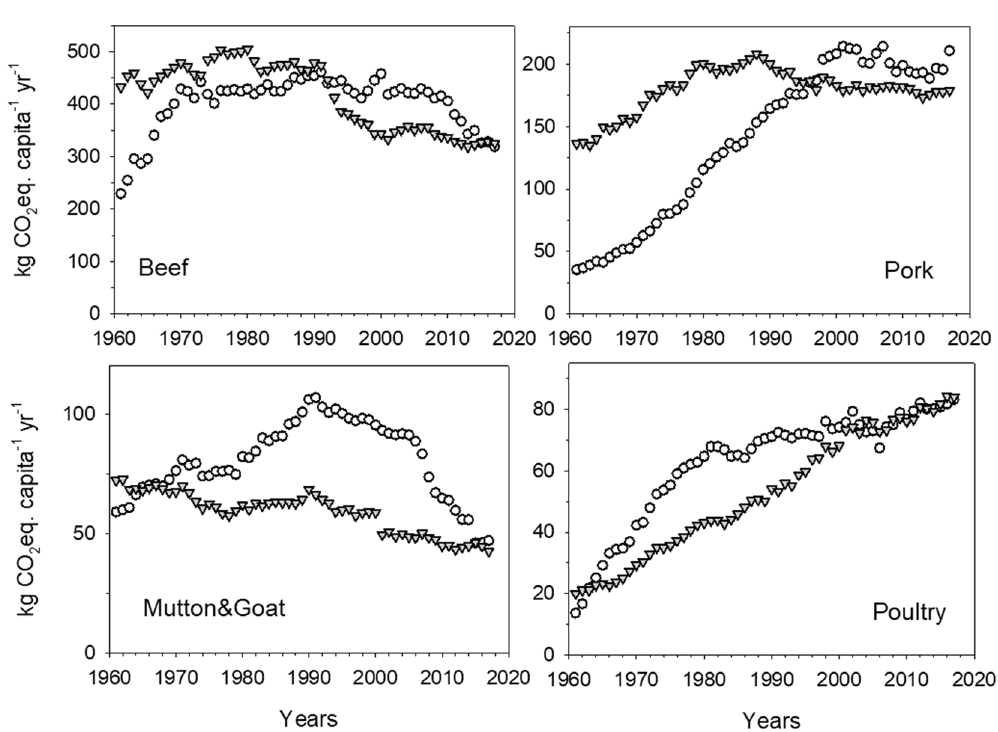
Figure 4. Annual per capita GHG emissions associated to beef, pork, mutton & goat and poultry meat consumption in European countries from 1961 to 2017. Total per capita yearly E GHG (kg CO 2 eq. capita −1 yr −1 ) associated to apparent consumption of each meat type (beef, mutton and goat, pork and poultry) by citizen in 7MED (white circles) and 21OTHER (grey triangles) countries from 1961 to